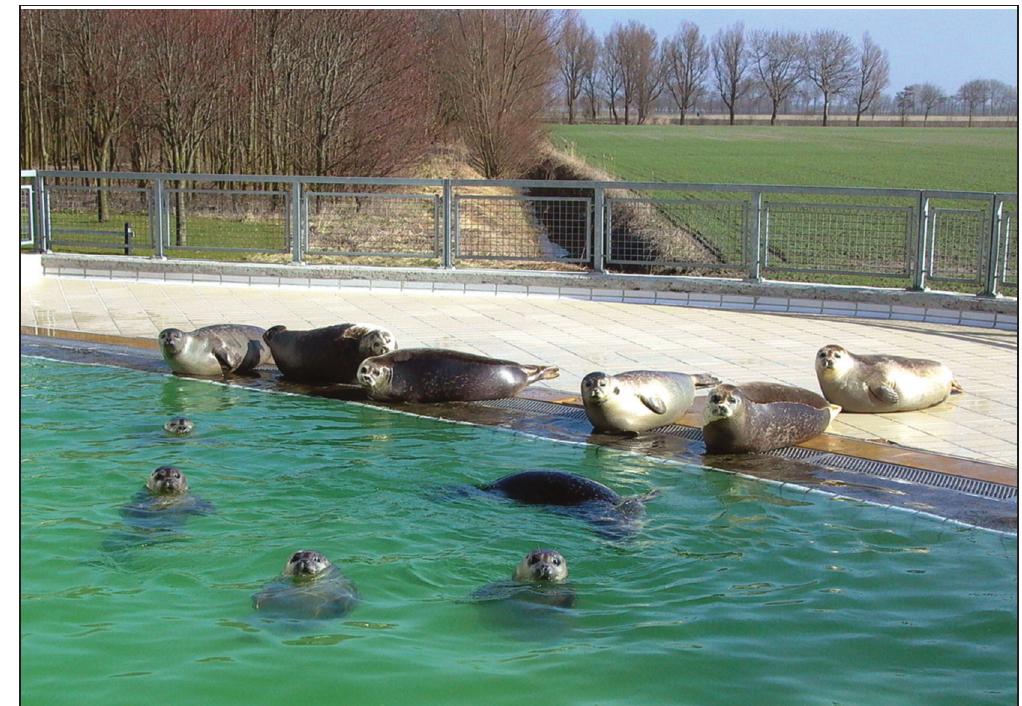
Fig. 9. Harbour seals in the last stage before